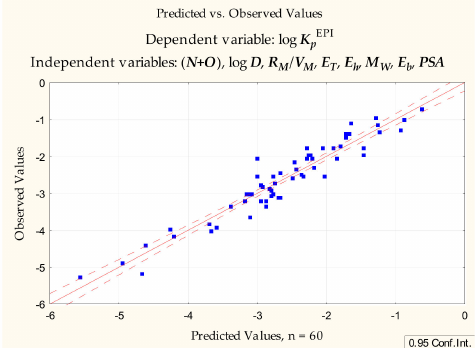
Figure 5. Equation (10), predicted vs. observed